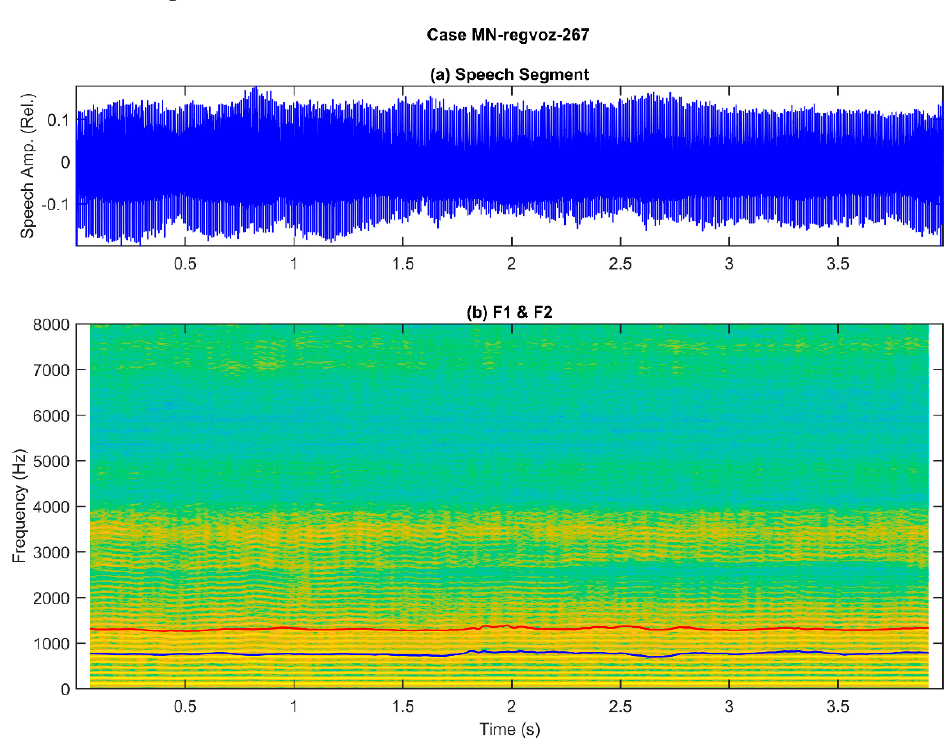
Figure 1. Example of a sustained utterance of vowel [a:] from a normative subject (male, 37 years old): ( a ) original speech signal, showing slight amplitude changes through the utterance; ( b ) spectrogram on the background and two formants in blue (first formant) and red (second formant). The harmonic spectrum (background) shows stable harmonics all over the recording, seen as horizontal yellow parallel bands, which extend from 120 Hz to almost 4000 Hz, indicating a moderate voice quality produced by a normal larynx function. The first two formants (blue and red lines) show some fluctuations, especially apparent from 1.8 s until 3.5 s, indicating a possible slight mandibular movement during phonation, as both lines maintain a relatively constant separation.